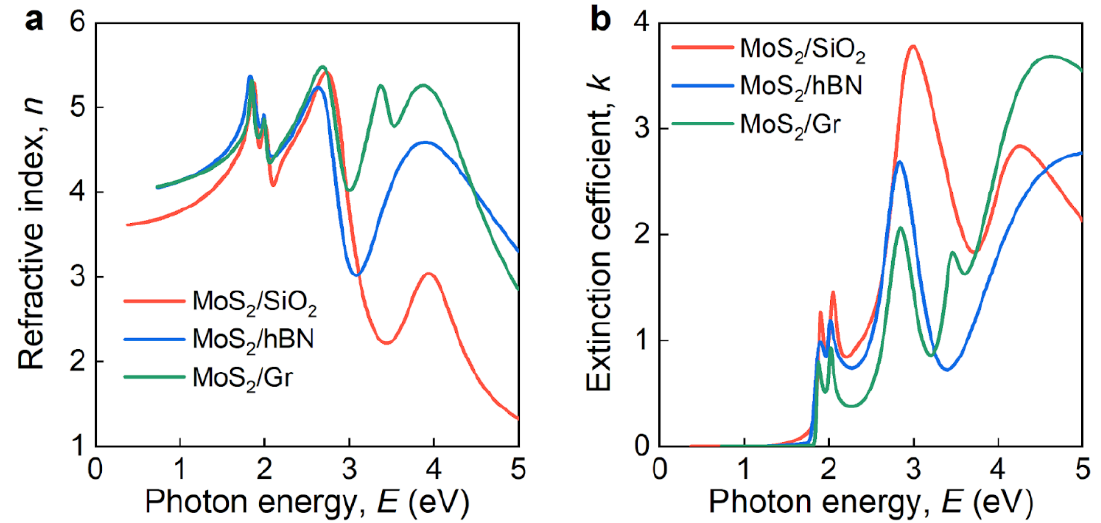
Figure 3. Optical constants of monolayer MoS 2 in heterostructures. ( a ) Refractive index and ( b ) extinction coefficient.